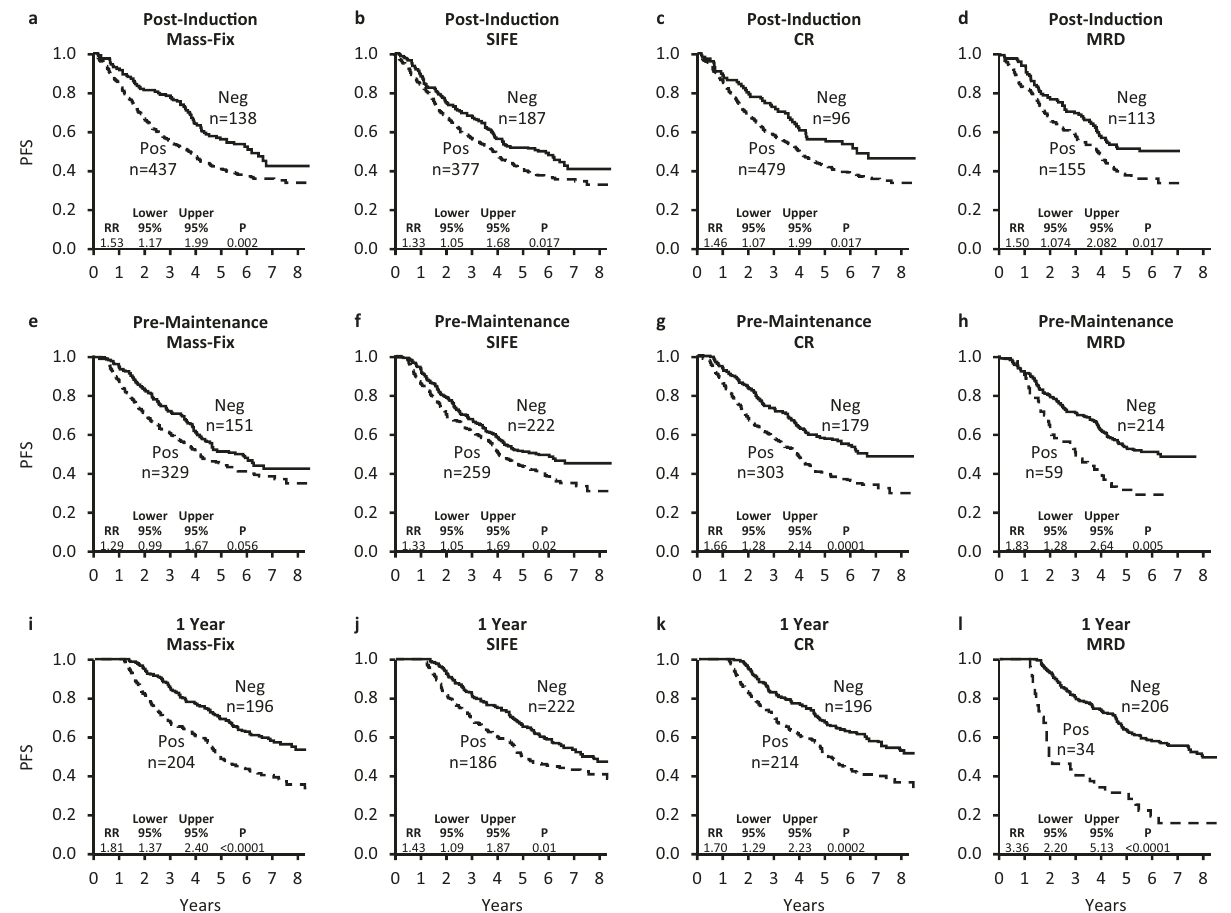
Fig. 2 Progression free survival based on response measurement at the time points. a – d post-induction sample; d – h pre-maintenance sample; i – l 1 year post enrollment